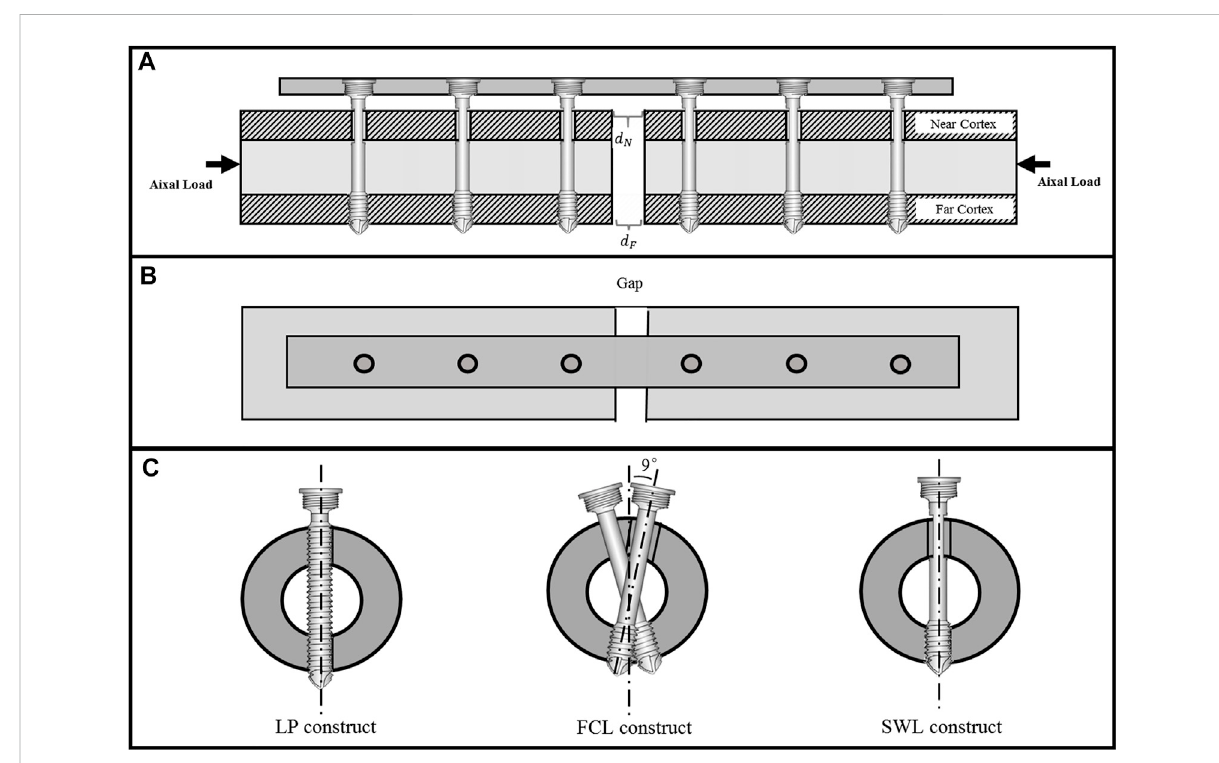
FIGURE 2 Schematic diagram of sandwich composite metal locking screw for far cortical locking construct. (A) Schematic diagram of the position and structuralcross-sectionofthecompositemetalscrewofthesandwichstructure, (B) thetopviewofthestructureand (C) thecomparisondiagramof lockedplating(LP),farcorticallocking(FCL),andsandwichlocking(SWL)constructs:theproximalanddistalendsoftheLParealllocked,andtheFCL screws are staggered by 9 ° ; only the distal end is locked, and the proximal end is enlarged. The SWL screws are arranged in a straight line; only the distal end is locked and the proximal hole is not